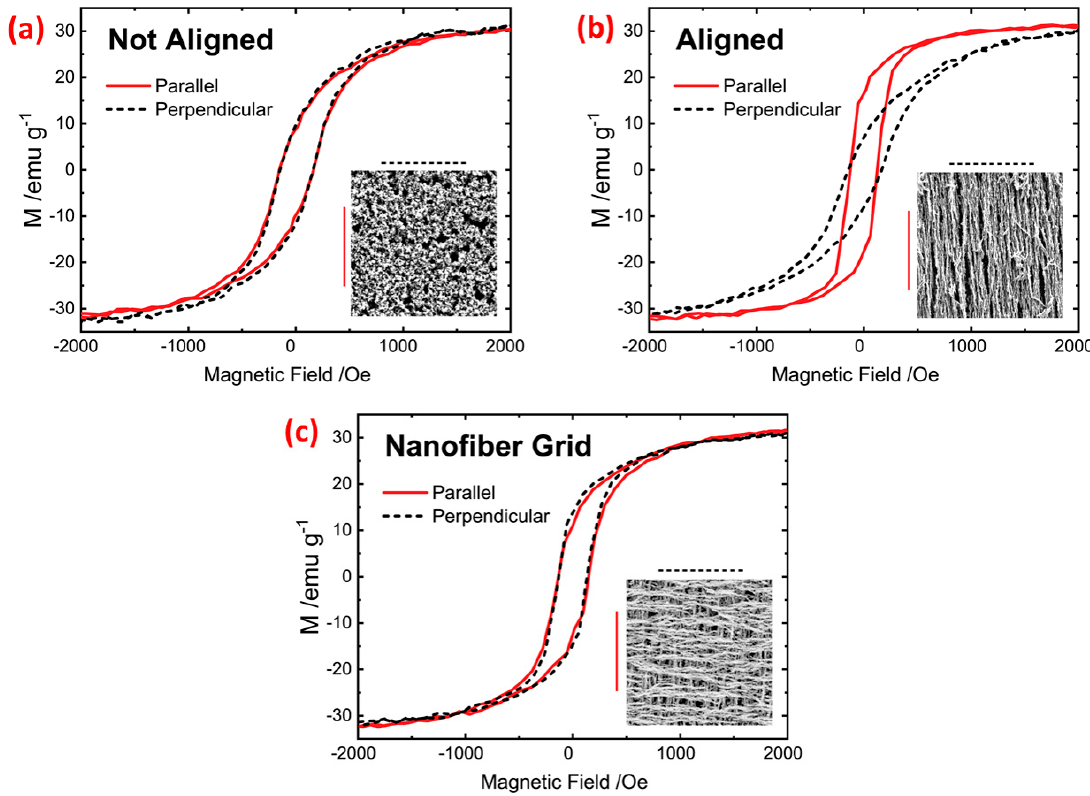
Figure 8. Magnetic characterization of Ni for particles ( a ) not aligned, ( b ) aligned (nanowires), and ( c ) in grid orientation.